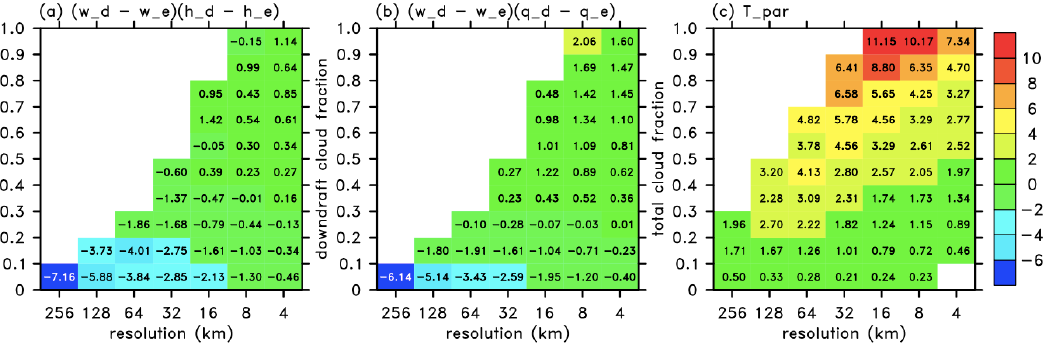
, ( b ) ). ( 𝑤𝑤 𝑑𝑑 − 𝑤𝑤 𝑒𝑒 )( ℎ 𝑑𝑑 − ℎ 𝑒𝑒 ) m/s K